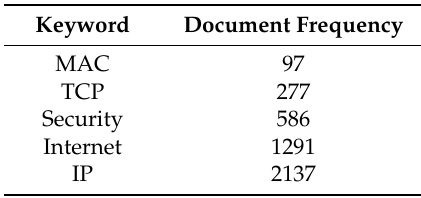
Table 1. The Document Frequency of Each Keyword.